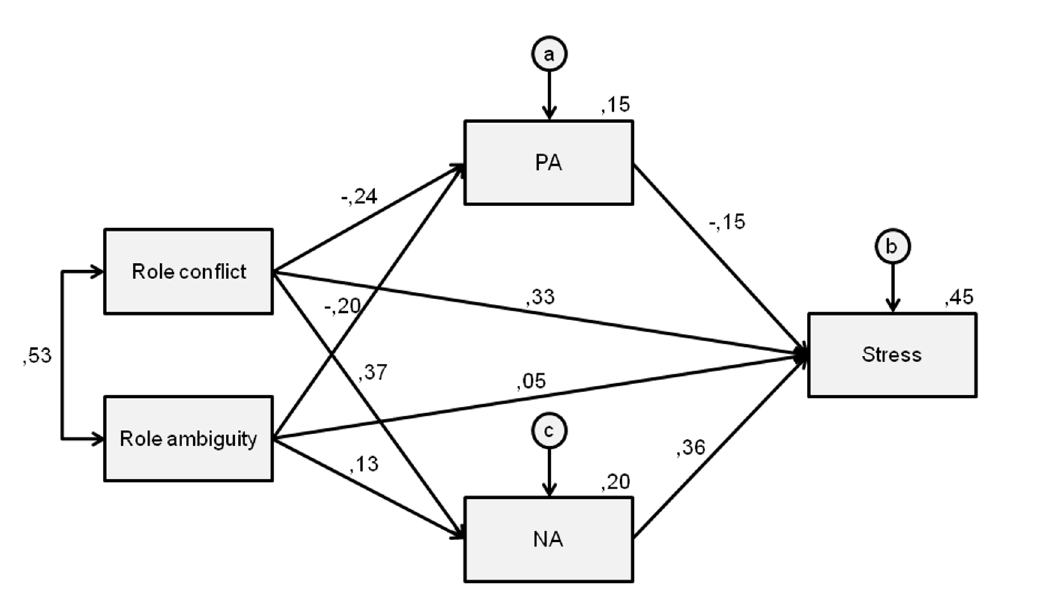
Figure 2. The best fitting structural model of the relations between role stressor, NA/PA, and Perceived